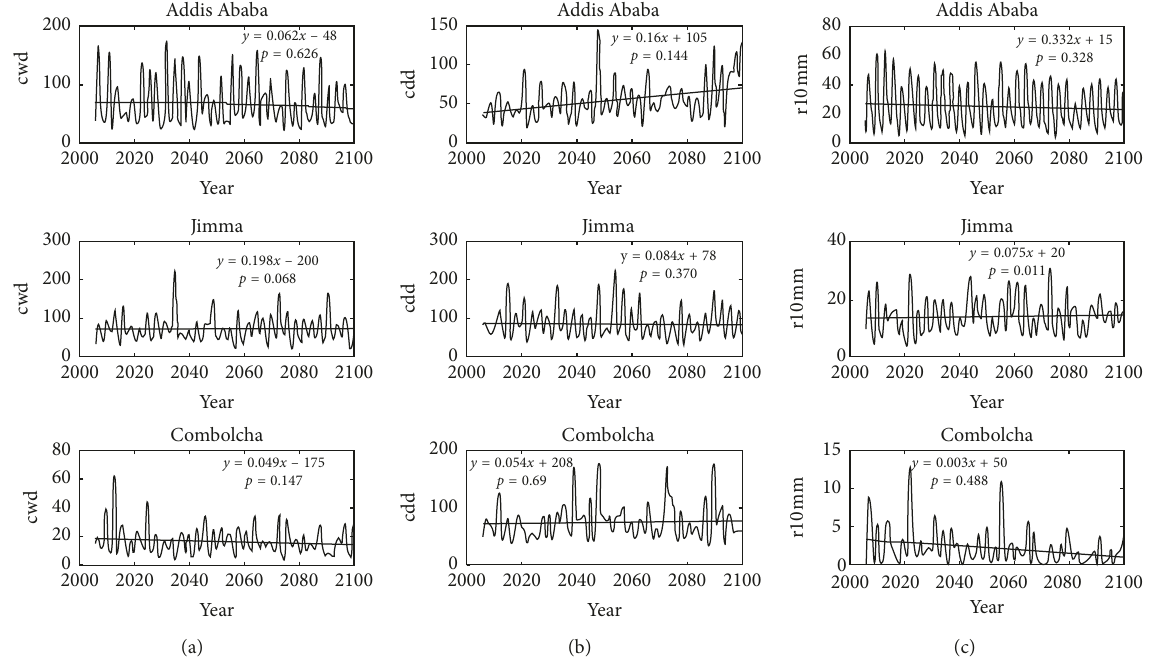
Figure 9: Time-series plot of ensemble consecutive wet days (a), consecutive dry days (b), and the number of heavy precipitation days at 10mm Table 4: Projected climate extreme trend from CMIP5 ensemble models of temperature and precipitation over Ethiopia. RCP4.5 RCP8.5 Elements Indices Addis Ababa Combolcha TMAXmean